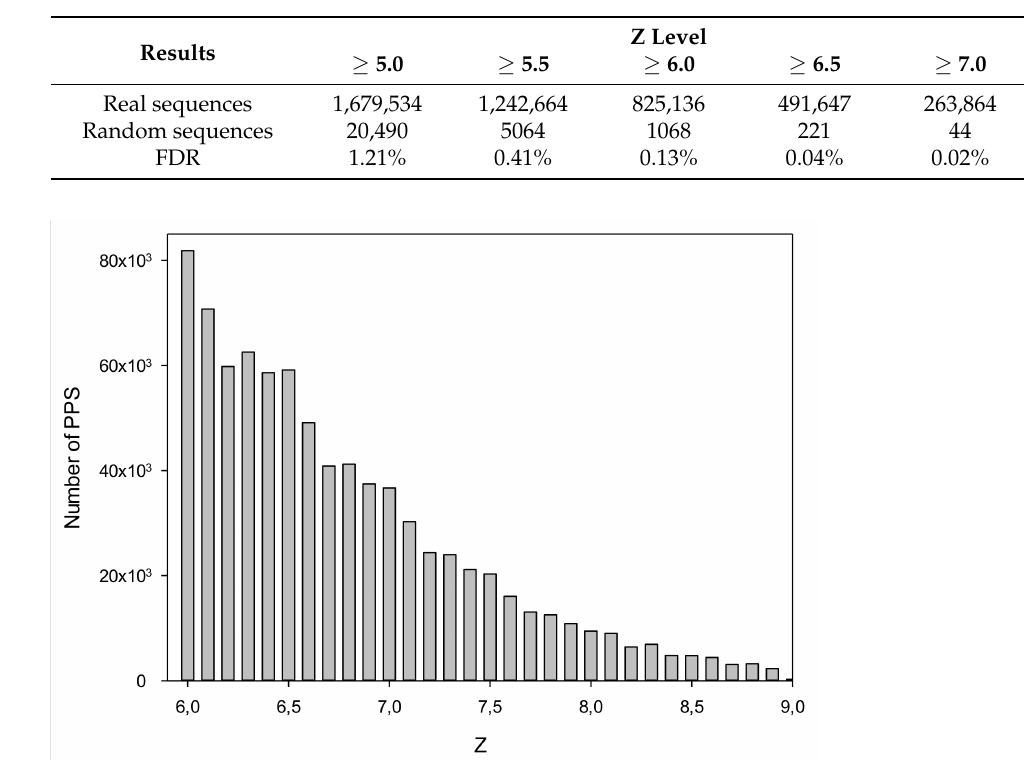
Figure 4. Histogram Z for